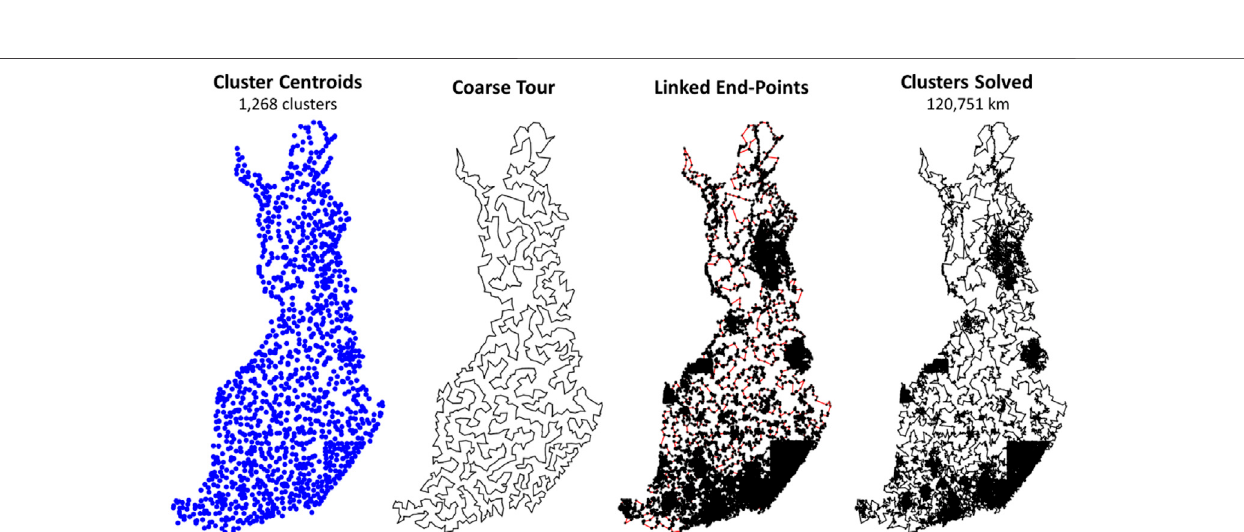
FIGURE 10 | Grid-based division demonstrated (A) and the centroids after repartitioning (B) .